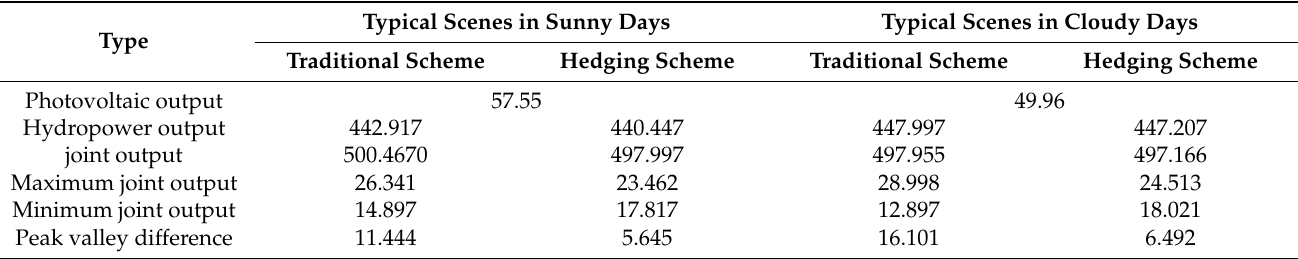
Table 4. Hydropower and photovoltaic joint output fluctuation value under the two schemes (10 4 kW).